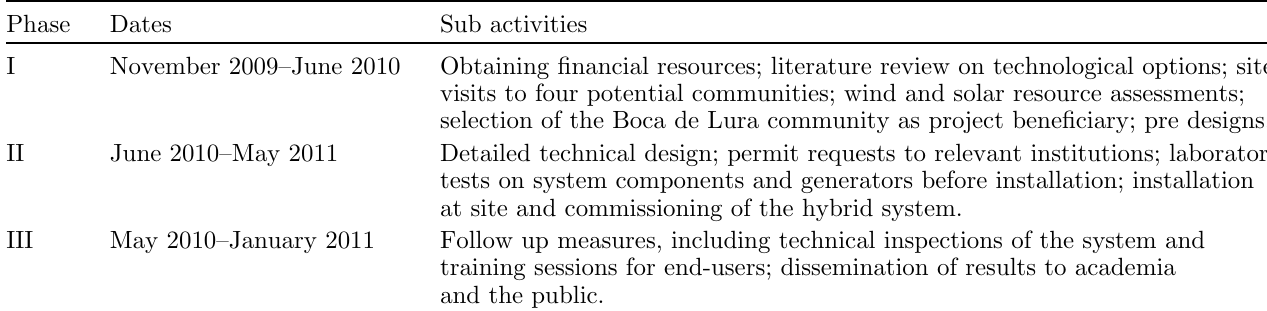
Table 1. Summary of main activities for project preparation, design and implementation [8].